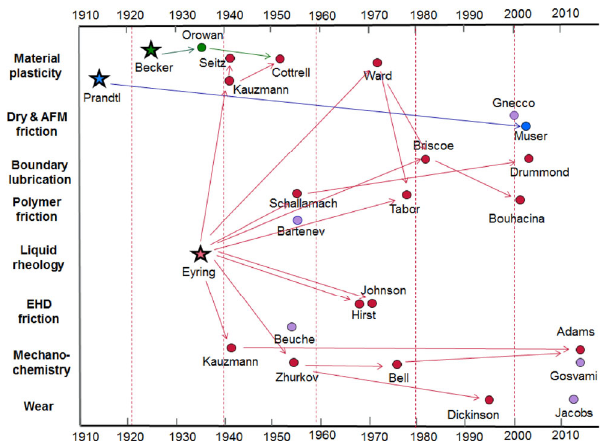
Fig. 18 Timeline showing connections in application of stress- augmented thermal